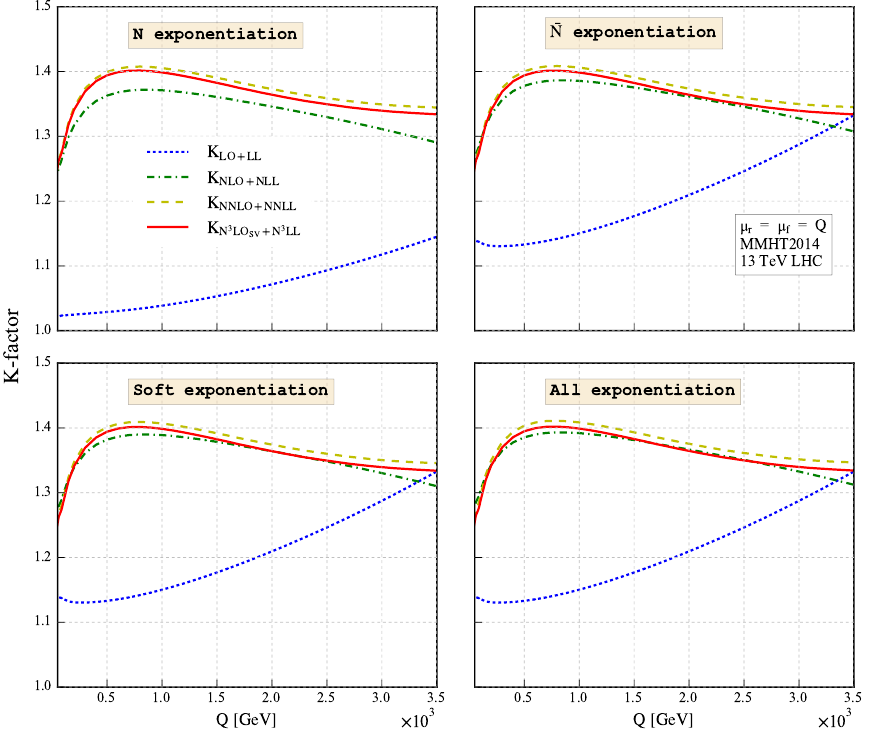
Figure 5 . The K-factors are shown for resummed results up to N 3 LL level for di(cid:11)erent threshold resummation approaches (discussed in the